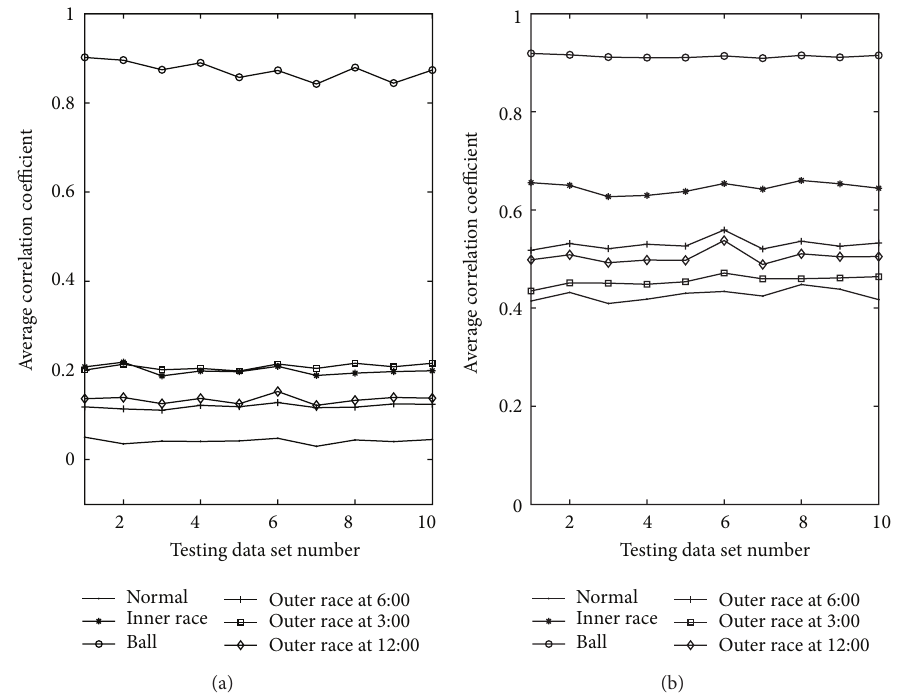
Figure 11: Detection results of data set B with a ball fault according to morphology spectrum correlation analysis: (a) signal based triangular SE; (b) flat